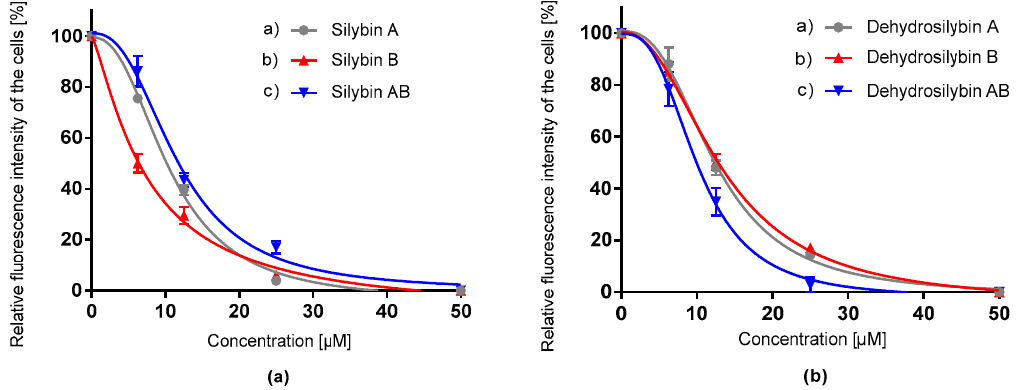
Figure 2. Relative oxygen radical absorption capacity (ORAC) of silybin diastereomers ( a ) and dehydrosilybin enantiomers ( b ). Data represent the average of three repetitions with corresponding standard error of the mean (SEM).